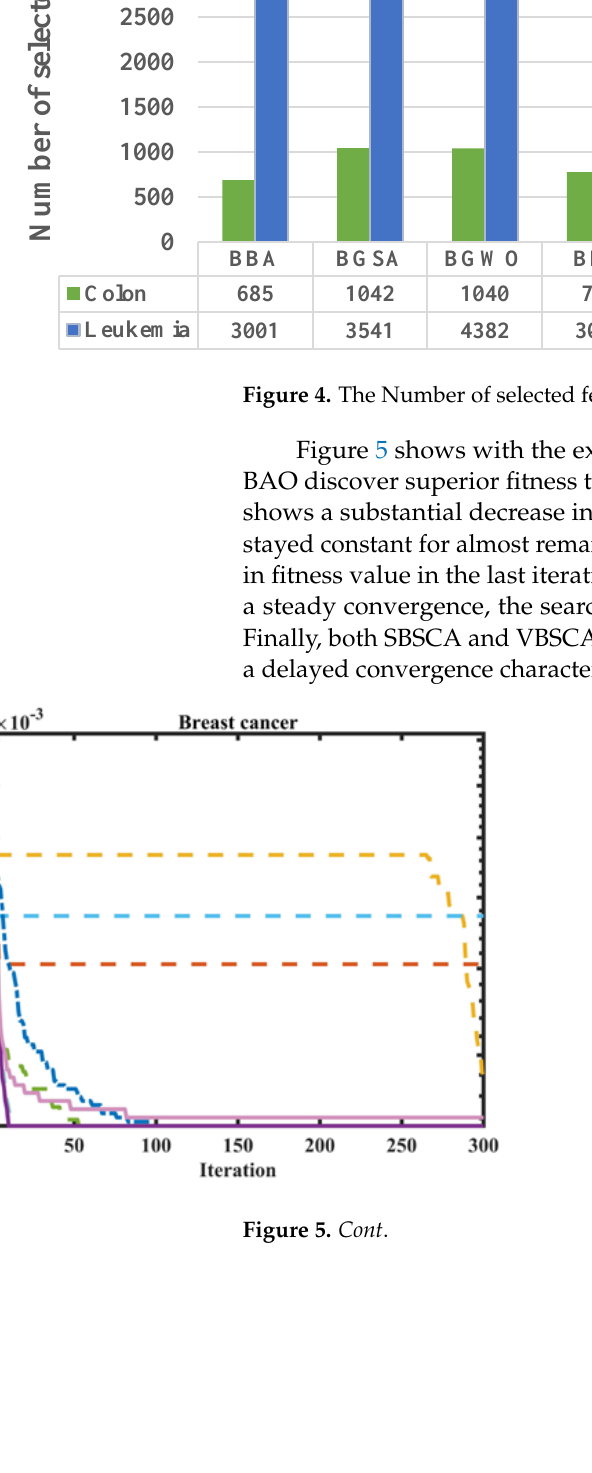
Figure 3. The Number of selected features comparison on small datasets.